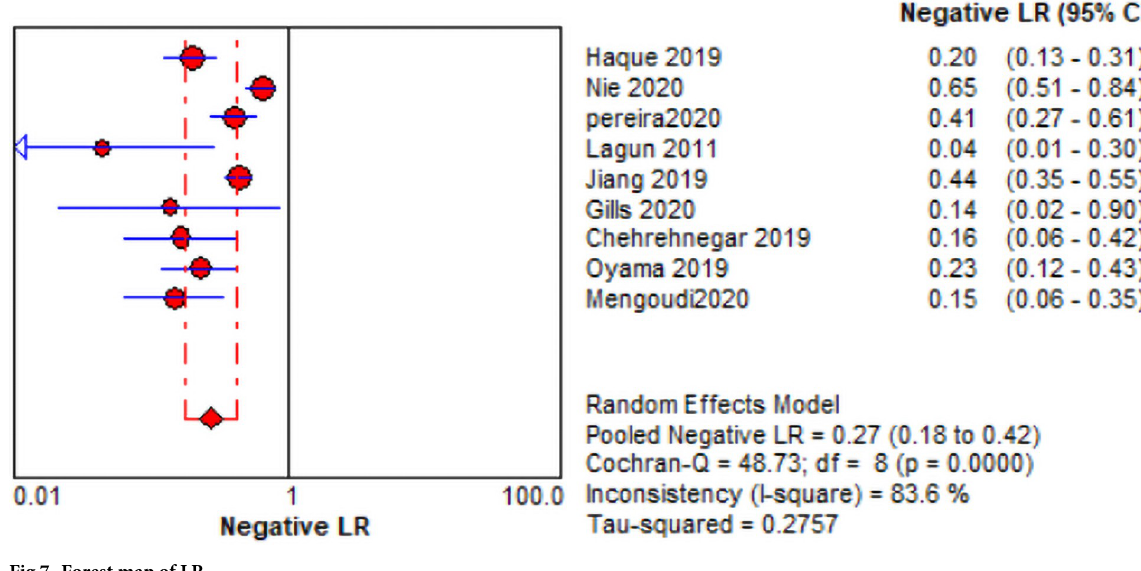
state. The change in the eye movement trajectory in patients with cognitive dysfunction is not a biological indicator rather than a state indicator, and therefore does not depend on the local subtle movements. As long as the patient displays retained the basic movement of the oculo- motor nerve and muscles, ET remains a helpful tool [18]. Control of eye movement relies on extensive brain structures and networks which are often damaged during the disease [37, 38]. Eye-tracking metrics bridge brain behavioral function and neural mechanisms to reflect work- ings within the brain [39, 40]. For example, multiple areas of the cerebral cortex, superior